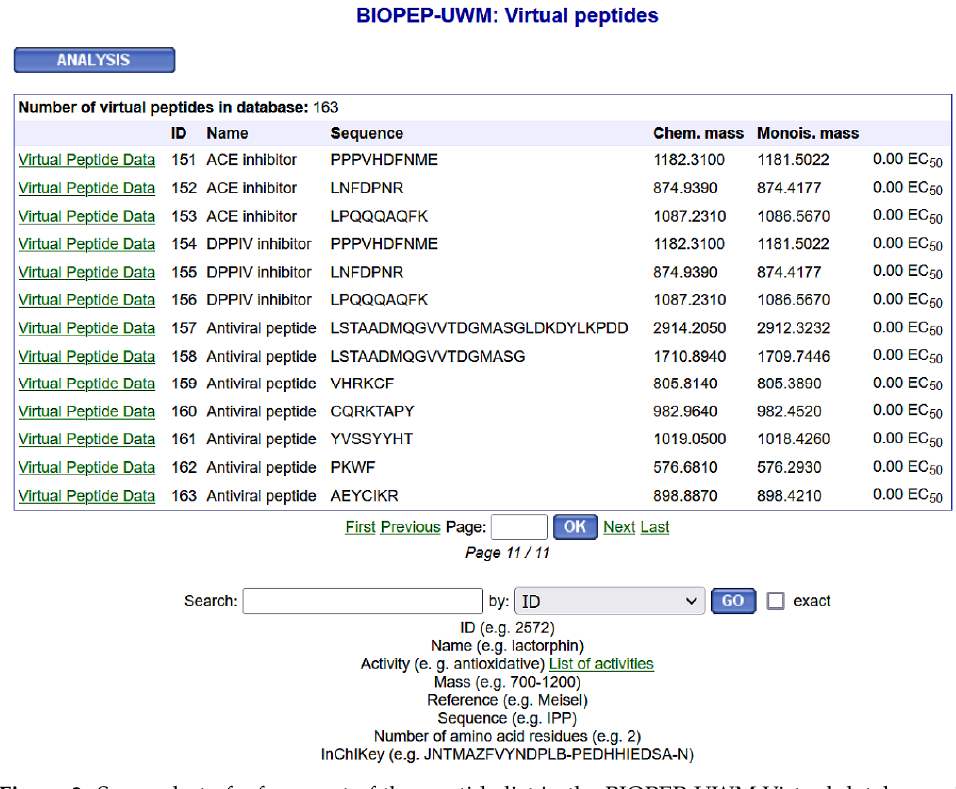
Figure 3. Screenshot of a fragment of the peptide list in the BIOPEP-UWM Virtual database with search options. Links to individual peptide cards are presented in the left column.